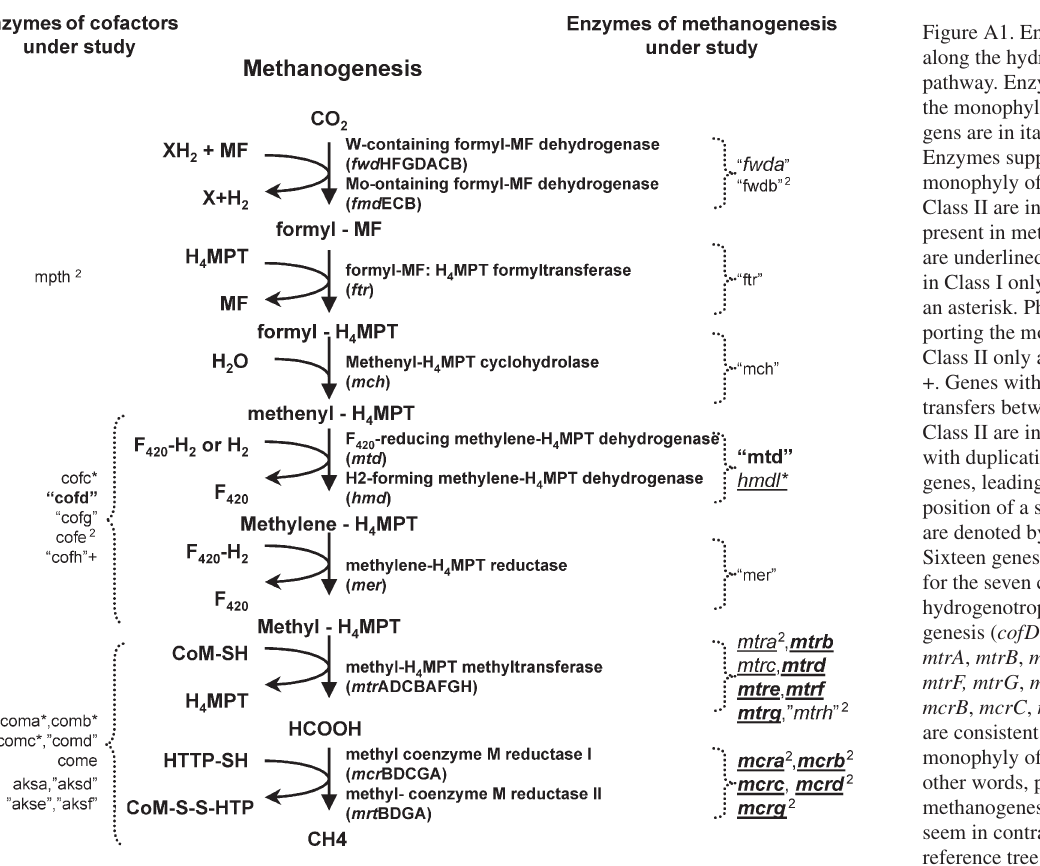
Figure A1. Enzymes are listed along the hydrogenotrophic pathway. Enzymes supporting the monophyly of methano- gens are in italics (BV >75%). Enzymes supporting the monophyly of both Class I and Class II are in bold. Enzymes present in methanogens only are underlined. Genes present in Class I only are indicated by an asterisk. Phylogeny sup- porting the monophyly of Class II only are indicated by a +. Genes without lateral gene transfers between Class I/ Class II are in quotes. Genes with duplication in methano- genes, leading to incongruent position of a species in the tree are denoted by a superscript 2. Sixteen genes out of 20 coding for the seven core enzymes of hydrogenotrophic methano- genesis ( cofD , fwdA , hmdI , mtrA , mtrB , mtrC , mtrD , mtrE , mtrF, mtrG , mtrH , mcrA , mcrB , mcrC , mcrD and mcrG ) are consistent with the monophyly of methanogens. In other words, proteins of methanogenesis themselves seem in contradiction with the reference tree based